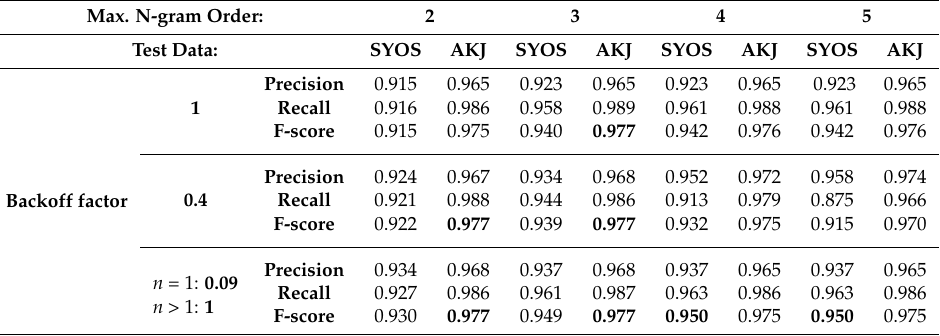
Table 6. Evaluation results—Stupid Backoff model (best results in